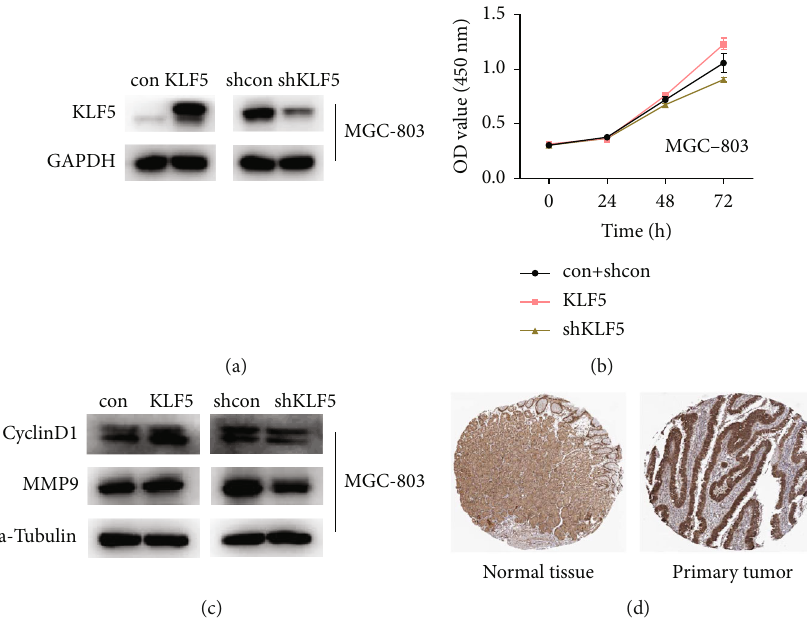
Figure 6: (a) MGC-803 cells were transfected with an overexpressing KLF5 plasmid to detect the expression levels of KLF5 protein. (b) CCK- 8 detects the e ff ect of KLF5 on cell proliferation. (c) MGC-803 cells were transfected with an overexpressing KLF5 plasmid and shKLF5 plasmid to detect the expression levels of CyclinD1 and MMP9 proteins. (d) Immunohistochemical analysis of KLF5 expression in stomach cancer and normal stomach tissue. Data derived from the Pathology Atlas